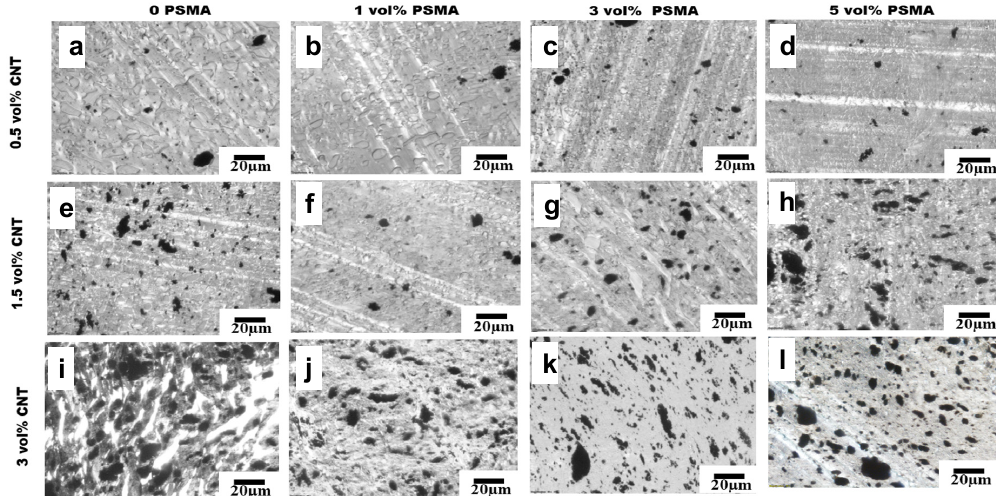
Figure 6. Mixing Order I. ( a – l ) Optical micrographs of PS-PSMA/aPA/CNT polymer blend nanocomposites. Going from left to right, the PSMA concentration in the blend increases and going from top to bottom, the CNT concentration in the PBN increases.